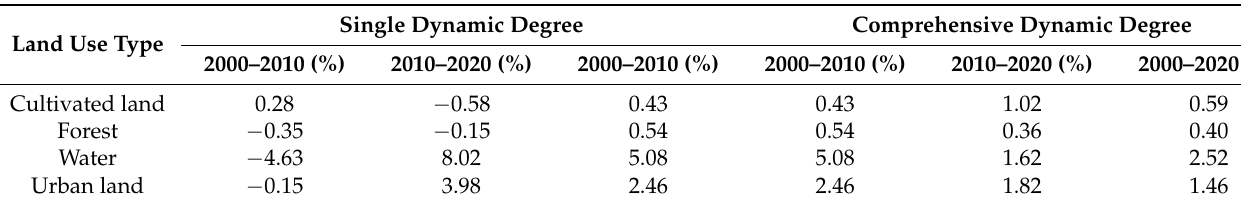
Table 3. Dynamic degree of land use change in Qishan from 2000 to 2020.